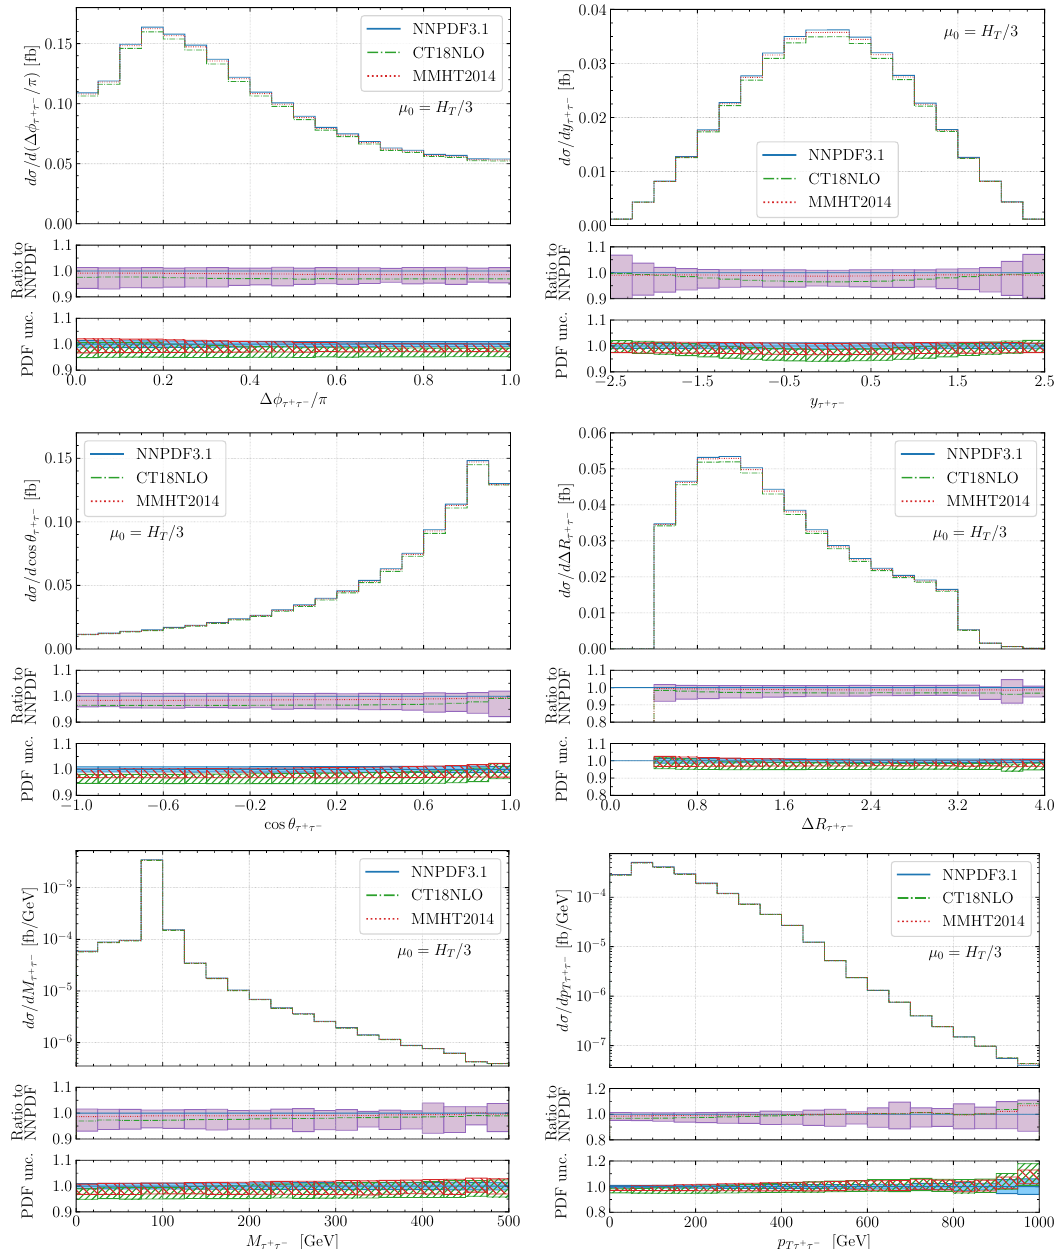
Figure 9 . Differential cross-section distributions for pp → e + ν e µ − ¯ ν µ b ¯ b τ + τ − + X at the LHC √ with s = 13 TeV as a function of ∆ φ The upper panel shows the absolute NLO QCD predictions for three different PDF sets with µ R = µ F = µ 0 = H T / 3 . The middle panel displays the ratio to the result with the default NNPDF3.1 PDF set as well as its scale dependence. The lower panel presents the internal PDF uncertainties calculated separately for each PDF